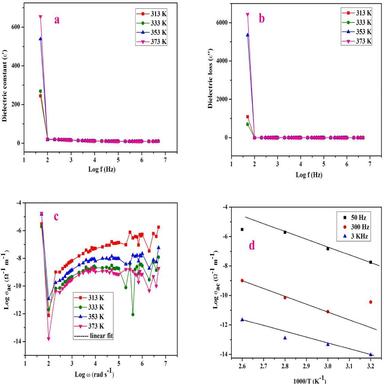
Plot of (a) Log f vs. dielectric constant (b) Log f vs. dielectric loss (c) Log σac vs. log ω and (d) Log σac vs. 1000/T.